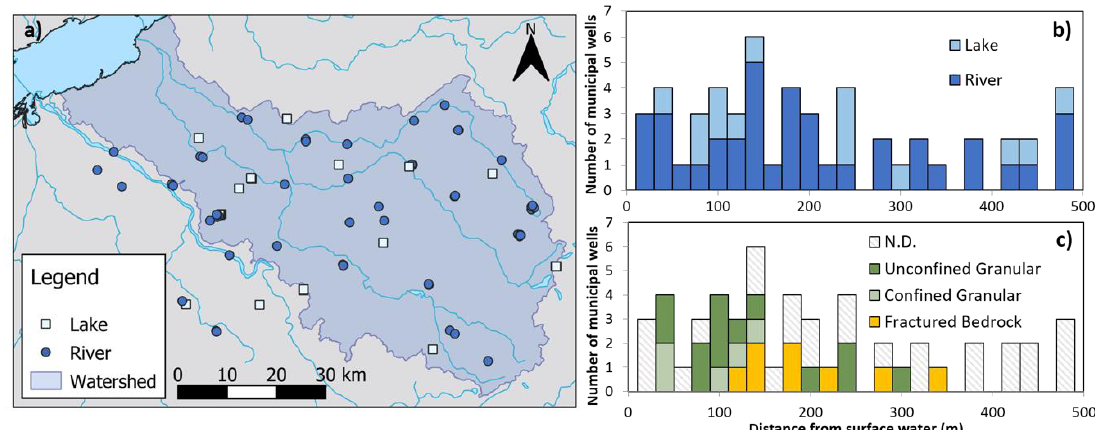
Figure 6. ( a ) The spatial distribution of municipal wells in the Nicolet area that are located at less than 500 m from lakes and rivers in area #2 and the distribution of wells according to ( b ) the type of surface water and ( c ) the type of aquifer.